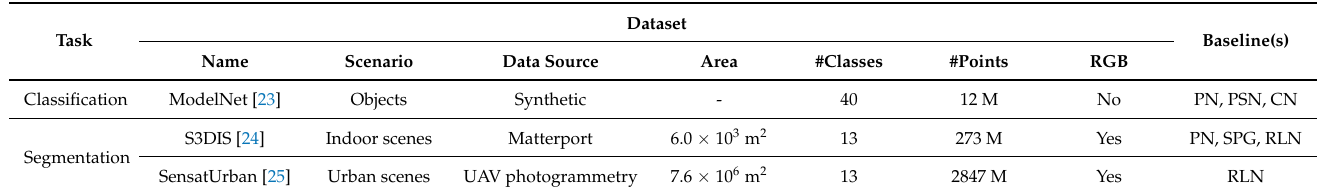
Table 1. Experimental setting. PN: PointNet [7]. PSN: Point Structuring Net [22]. CN: CurveNet [21].